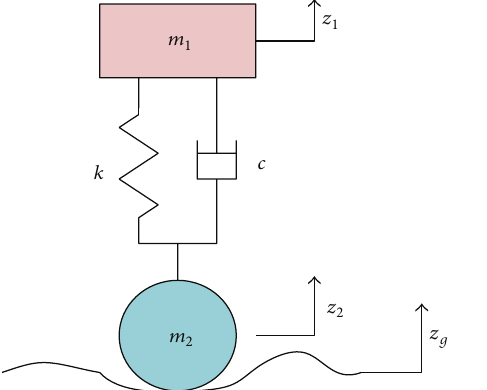
Figure 3: The quarter kinetic model of a manned lunar rover on a rigid road.